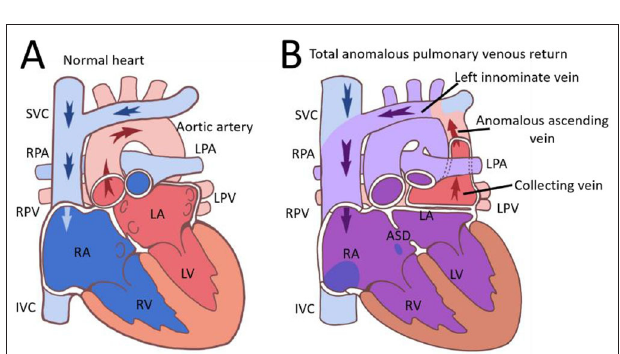
FIGURE 2 | A three-dimensional cardiac CT scan further delineated the supracardiac TAPVR in coronal view (A) and sagittal view (B) . Pulmonary veins drained into a collecting vein. Later followed by left upper pulmonary vein to form an anomalous dilated vertical vein which eventually drains into left innominate vein and superior vena cava. TAPVR, total anomalous pulmonary venous return.